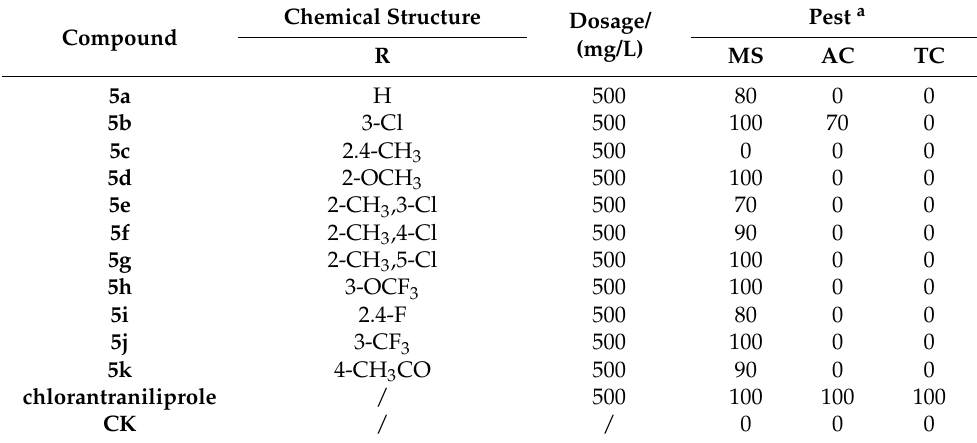
Table 1. Insecticide activities (percent inhibition/%) of 5a – 5k at 500 mg/L.